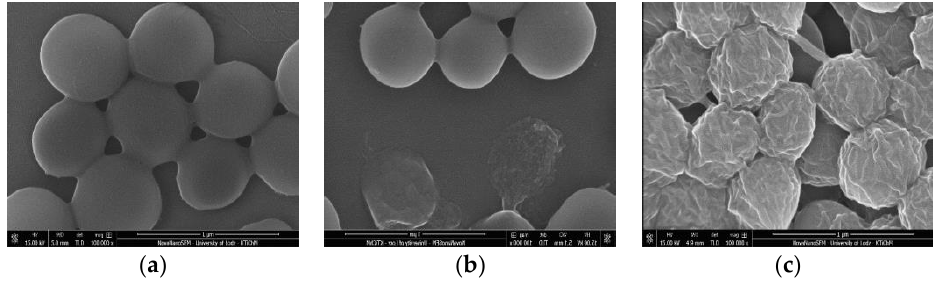
Figure 6. SEM images of S. aureus incubated with or without CS-GO- f and CS-PGO- f. ( a ) untreated, ( b ) treated of CS-GO- f , and ( c ) treated of CS-PGO- f. ( b ) treated of CS-GO- f , and ( c ) treated of CS-PGO- f